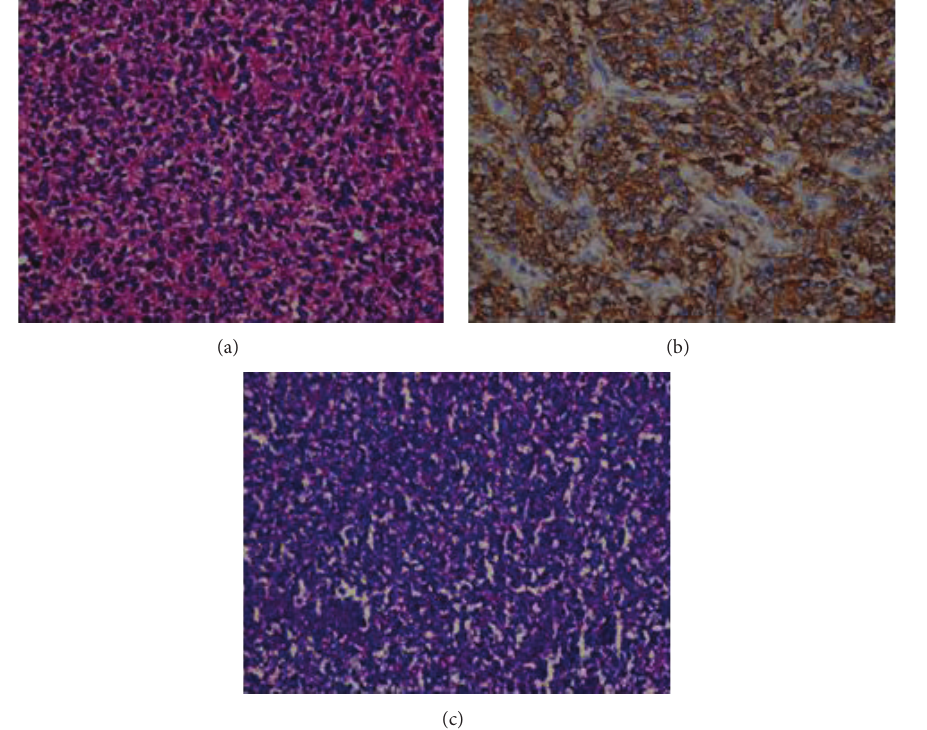
Figure 4: (a) Photomicrograph showing sheets of proliferating round cells, diffuse proliferation of cells with indistinct cytoplasm and small basophilic nuclei (HE × 400). (b) Strong and membranous CD99 immunoreactivity (CD99 immunohistochemical stain × 400). (c) shows abundant cytoplasmic glycogen in the cells of Ewing sarcoma with PAS stain. (PAS stain × 400).